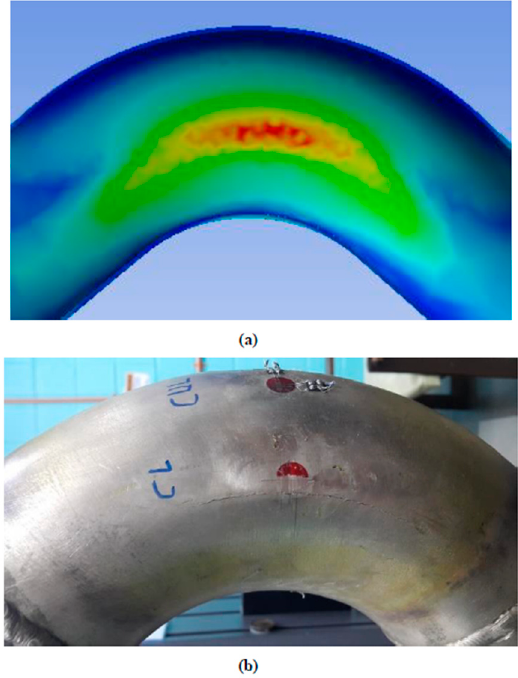
Figure 2. Distribution of effective stresses under in-plane bending (red area–at crown location shows the highest stress intensity), adapted from [19] with permission from wiley.com, 2019. ( a ) The FEA three-dimension failure illustration; ( b ) fatigue failure captured on the elbow after cyclic loading experiment.